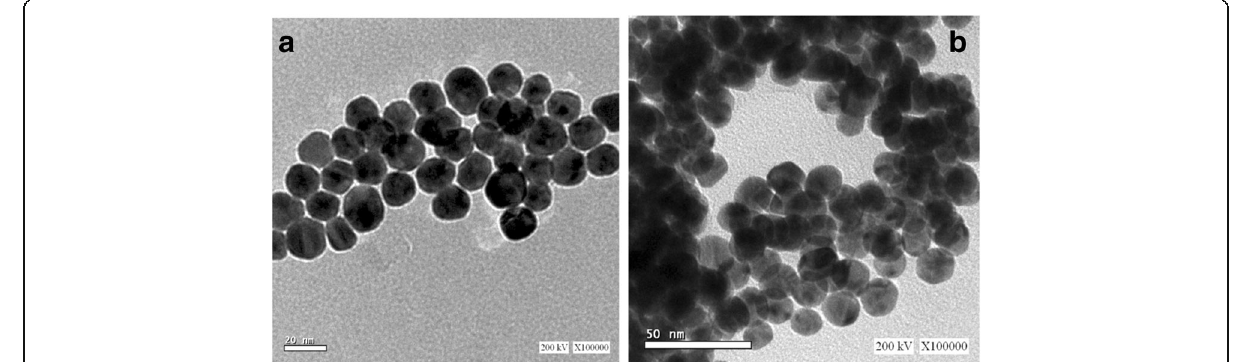
Fig. 2 TEM micrograph of a histidine – GNPs and b histamine – GNPs